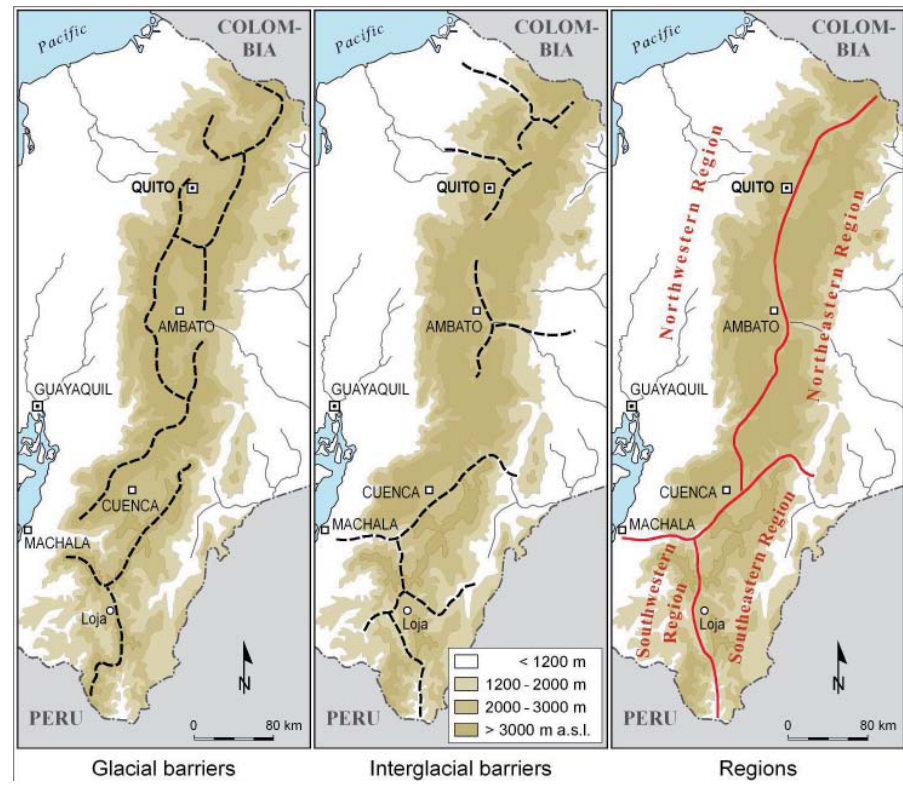
Figure 6: Possible migration barriers for plant species in the Ecuadorian Andes during the Pleistocene. Left: barriers due to Pleistocene glaciations. Centre: barriers due to dry areas in large valleys. Right: recent situation of four regions of endemism. Source: Jørgensen et al. (1995), from: Beck & Richter (2008), slightly